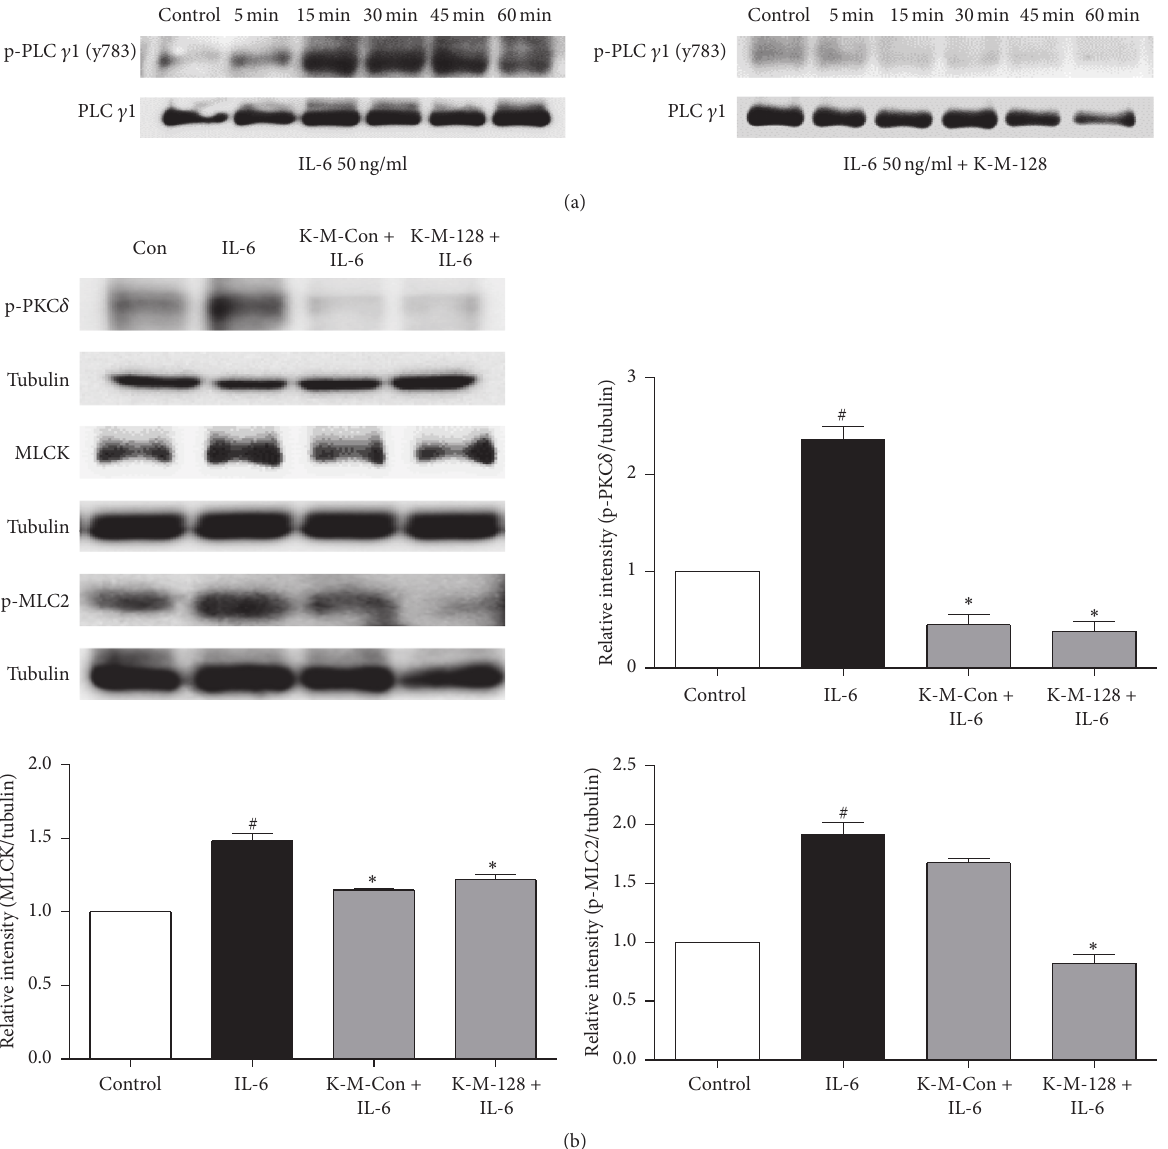
Figure 5: KIOM-MA/MA128 prevent the disruption of cytoskeleton by IL-6. (a) KIOM-MA/MA128 inhibited the IL-6-induced activation of PLC 𝛾 1. (b) Lysates were assayed for MLCK, MLC2, and PKC 𝛿 via Western blot. KIOM-MA/MA128 prevented the activation of MLCK, MLC2, and PKC 𝛿 induced by IL-6. The results are reported as the means ± SDs from 3 independent experiments. ∗ 𝑝 < 0.05 compared with the IL-6 treated group; # 𝑝 < 0.05 compared with the control